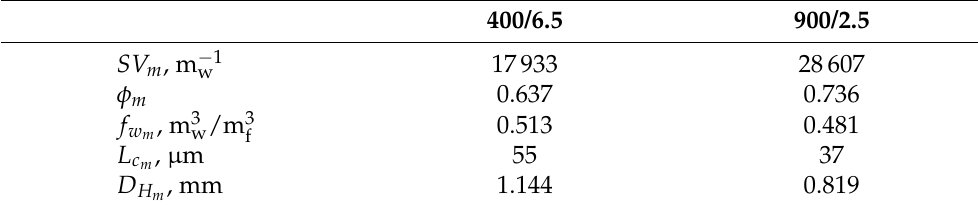
Table 1. Substrate geometrical